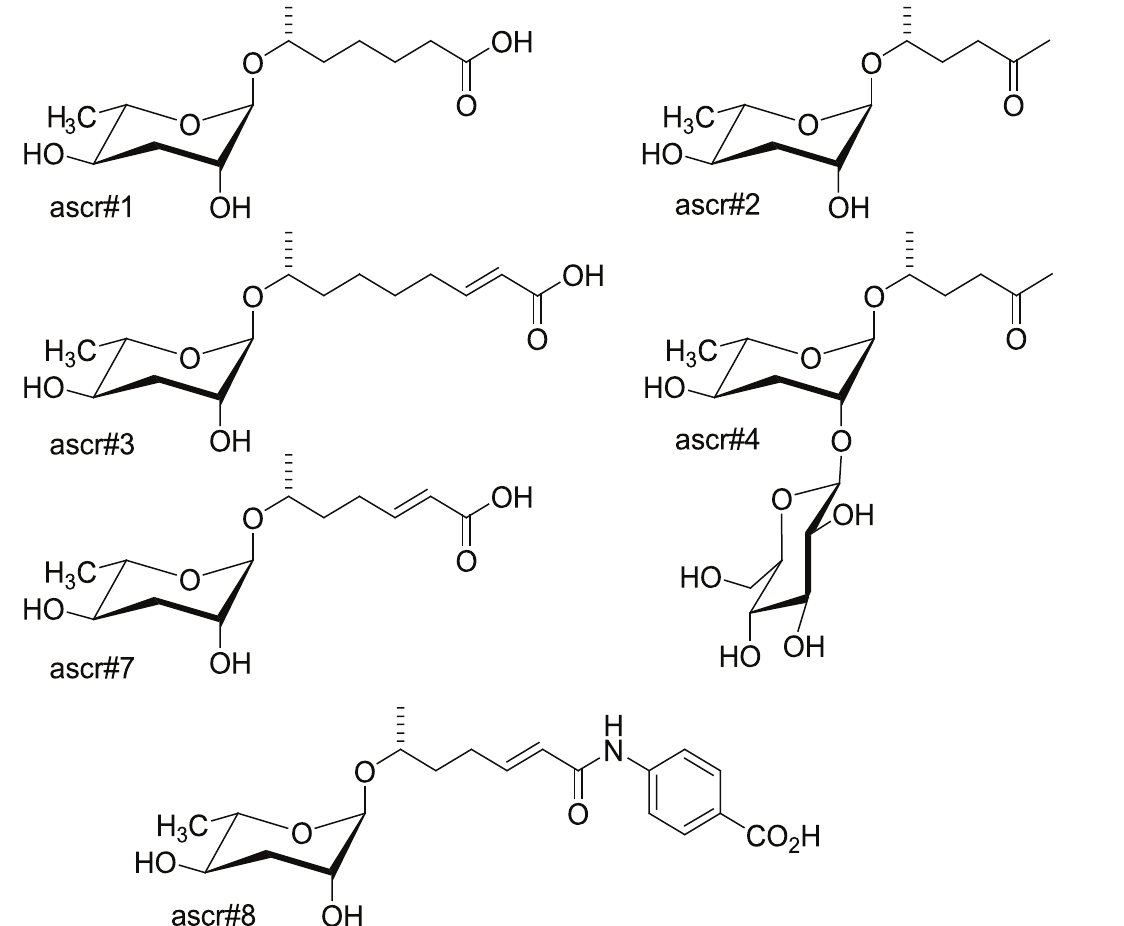
Figure 1. Ascarosides monitored in the study. Ascarosides consists of the sugar ascarylose linked to a fatty-acid-derived side chain that may contain a variety of functional groups.